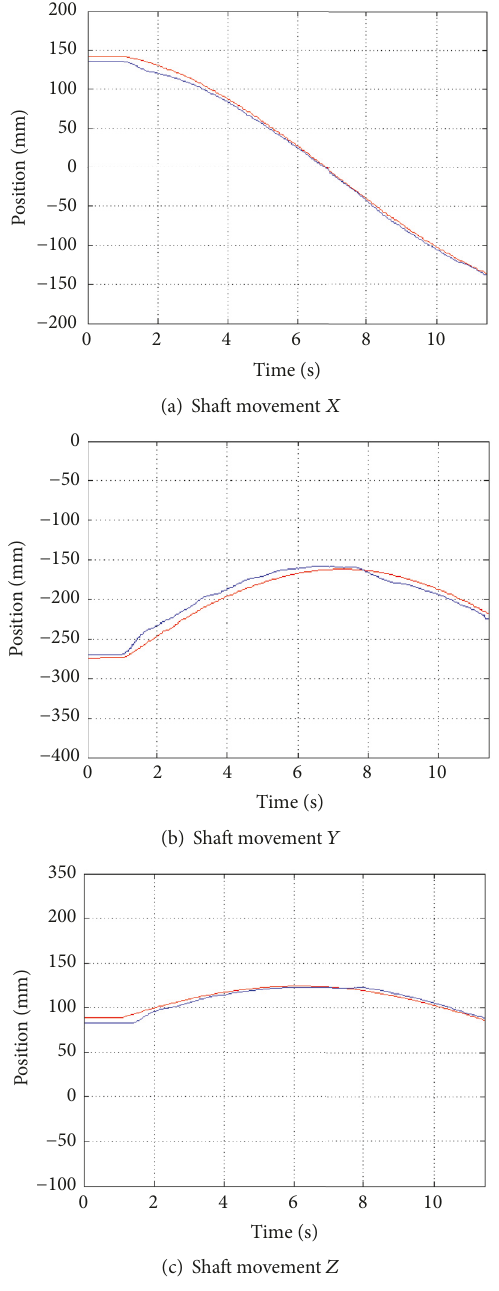
Figure 17: Cartesian movement of the MOVES command.